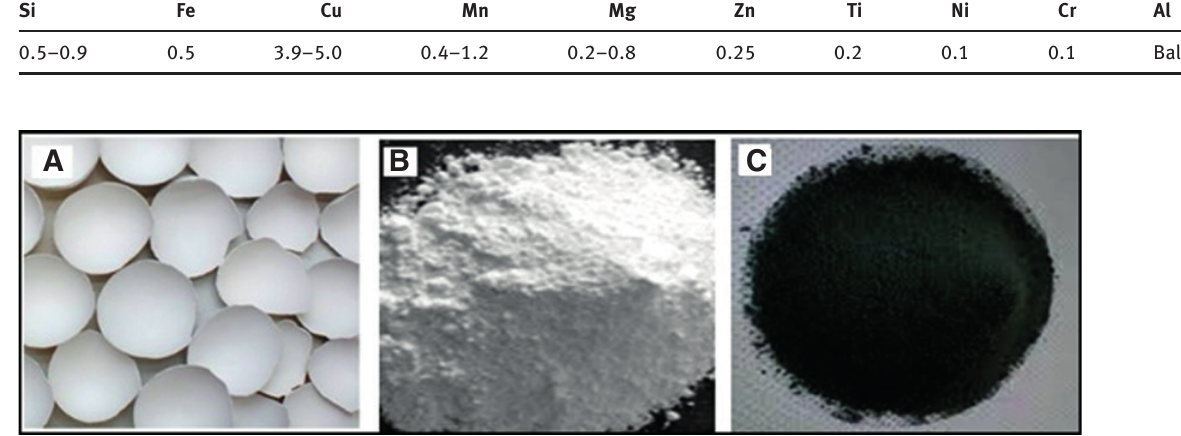
Table 1: Chemical composition of AA2014 alloy (wt.%). Si